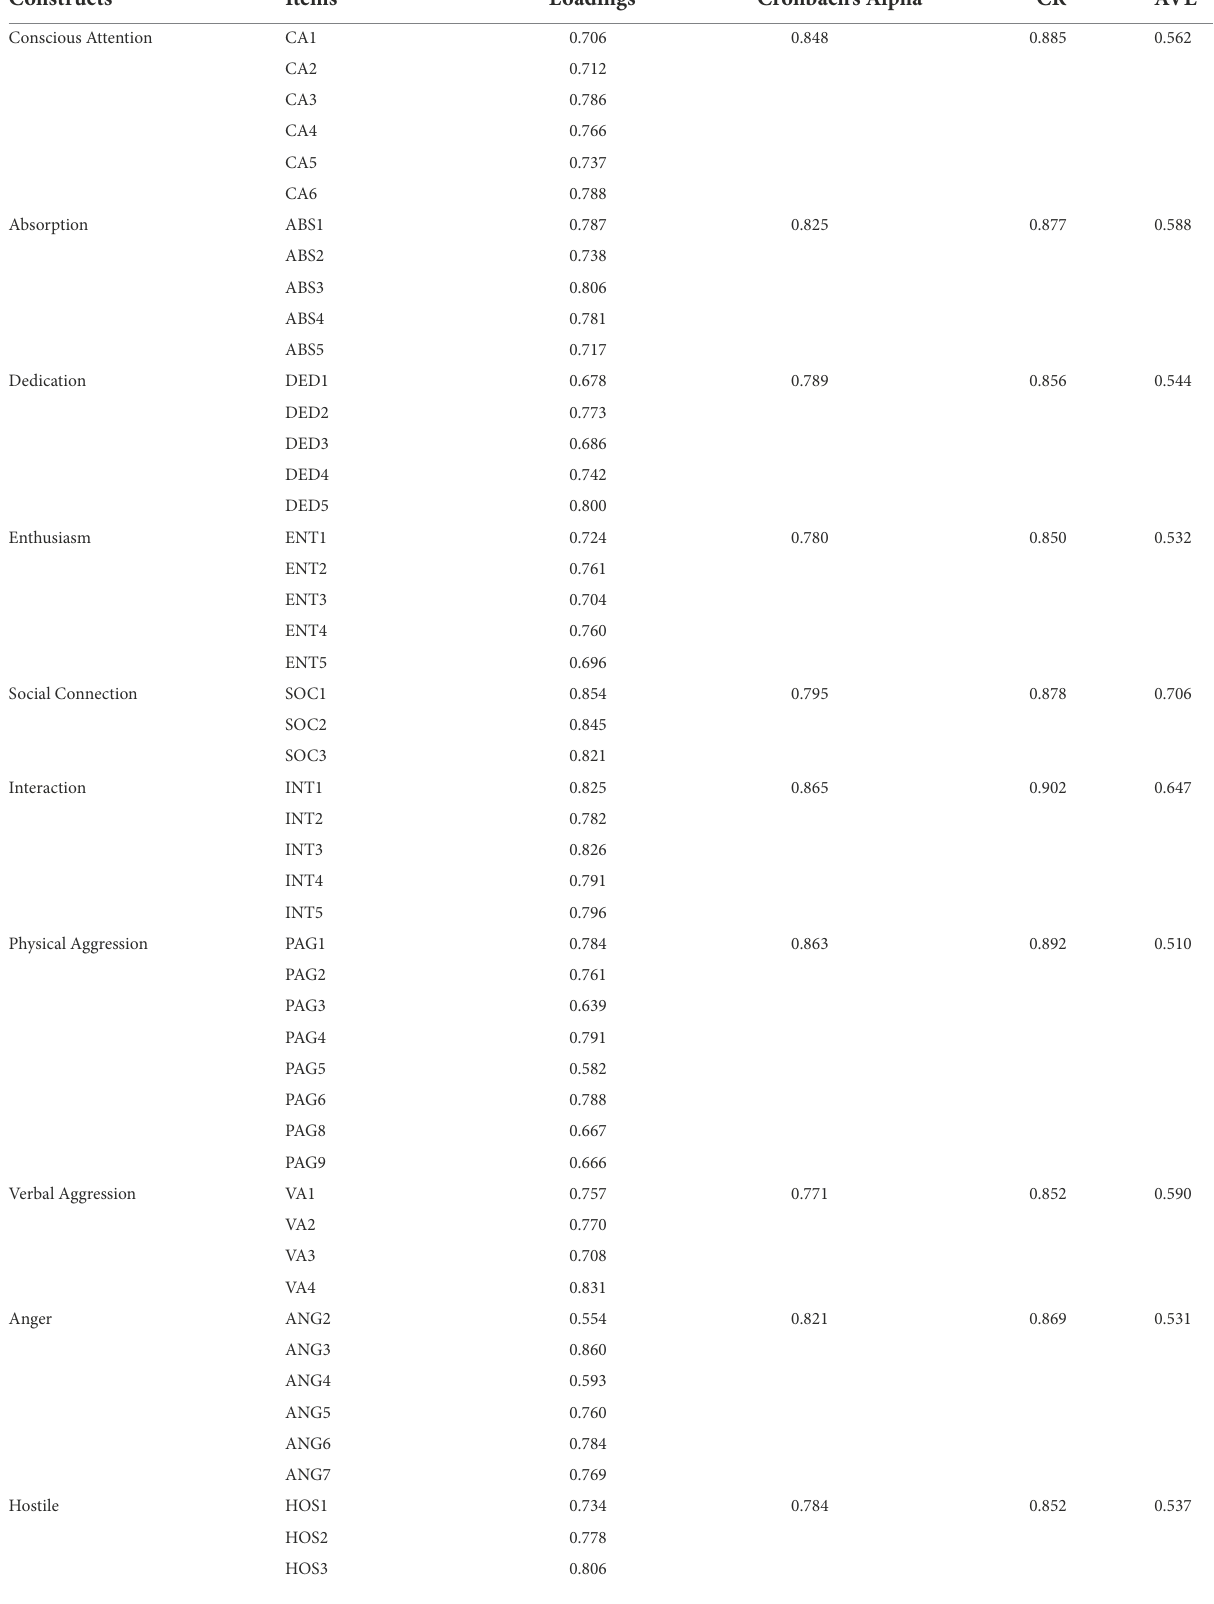
TABLE 2 Results of the assessment of the measurement model reflective